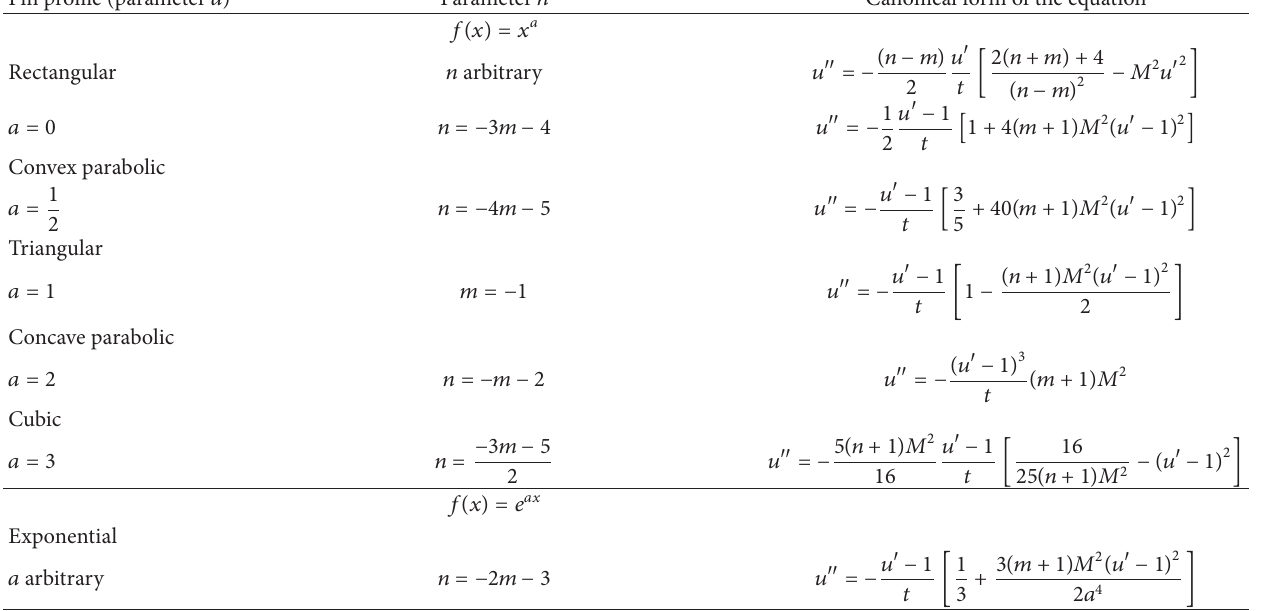
Table 11: The type of second-order equations admitting 𝐿 2 for 𝑚 ̸=𝑛 , 𝑛 ̸= − 1 and various 𝑓(𝑥) . Fin profile (parameter 𝑎